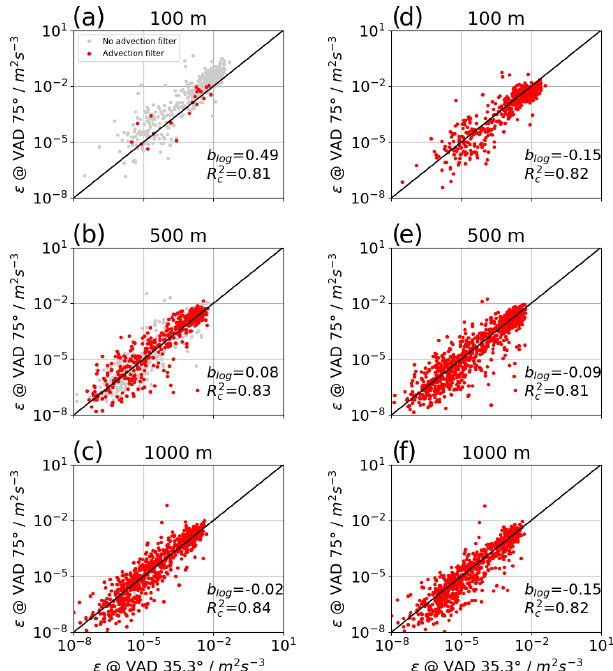
Figure 9. Scatterplot of lidar dissipation rate retrieval from VAD scans with a 75 ◦ elevation angle versus 35.3 ◦ . On the left, retrievals without advection correction are shown for three different levels at (a) 100m, (b) 500m, and (c) 1000m. On the right, the correspond- ing scatterplots with advection correction are presented (d–f) .